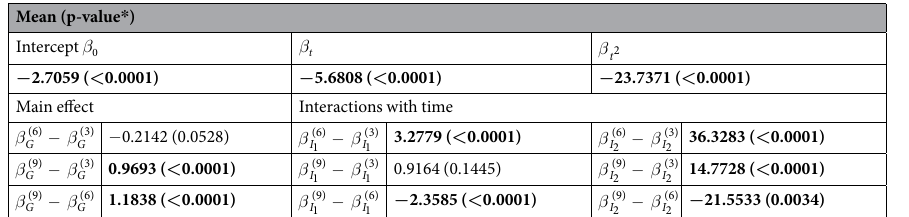
Table 4. The GLMM results of Light-On VMR from 1 to 30s for AB larvae at different stages. * p-values of these tests were adjusted using the Benjamini–Hochberg procedure to control for type I